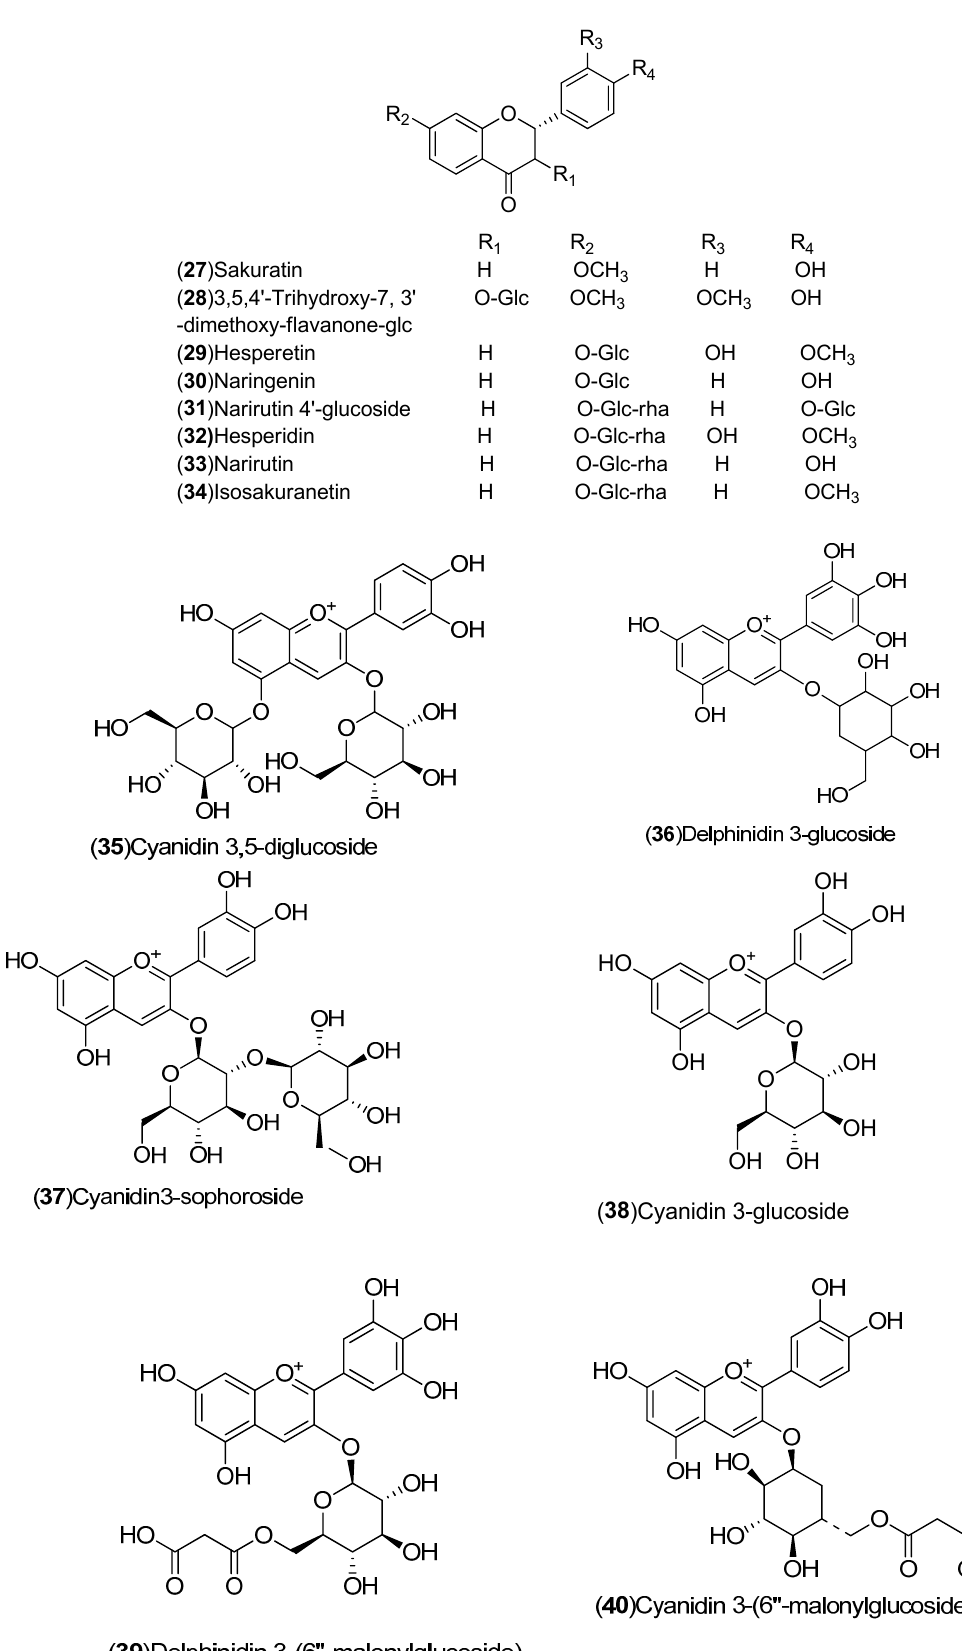
Figure 1. Cont. Figure 1.